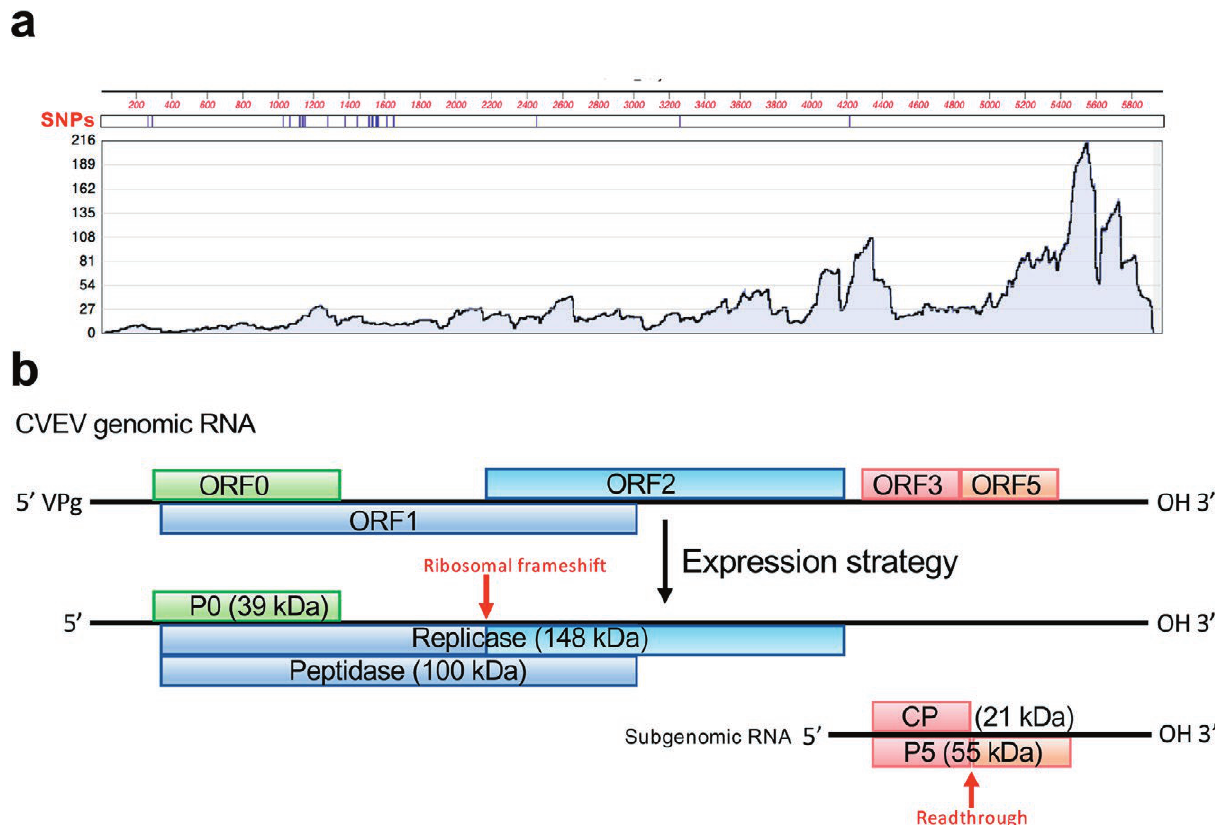
Figure 1. (a) CVEV genome coverage by HTS reads. Alignments were performed using the Bowtie program and the CVEV variant NC_021564 as the reference sequence. Nucleotide (nt) positions are indicated at the top. Single nucleotide polymorphisms (SNPs) are indi- cated by vertical lines below the respective positions. (b) Genome organization and expression strategy of CVEV. Putative ORFs are indi- cated by boxes. The predicted proteins expressed from the genomic and subgenomic RNAs are indicated by boxes in the lower part of the